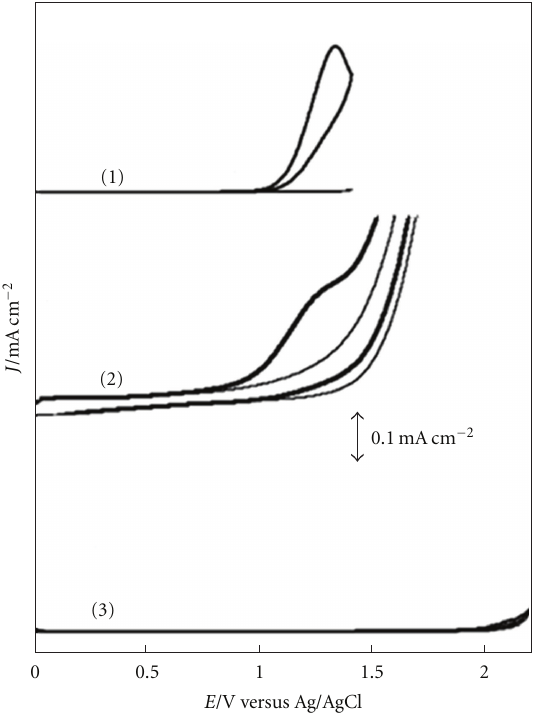
Figure 5: Cyclic voltammograms of 0.1M PBS (pH 2.1) at the as- deposited (hydrogen-terminated) BDD (1), glassy carbon (2), and oxygen-terminated BDD (3) electrodes with (bold line) and without (thin line) the presence of 100 µ M oxalic acid. The scan rate was 100 mVs − 1